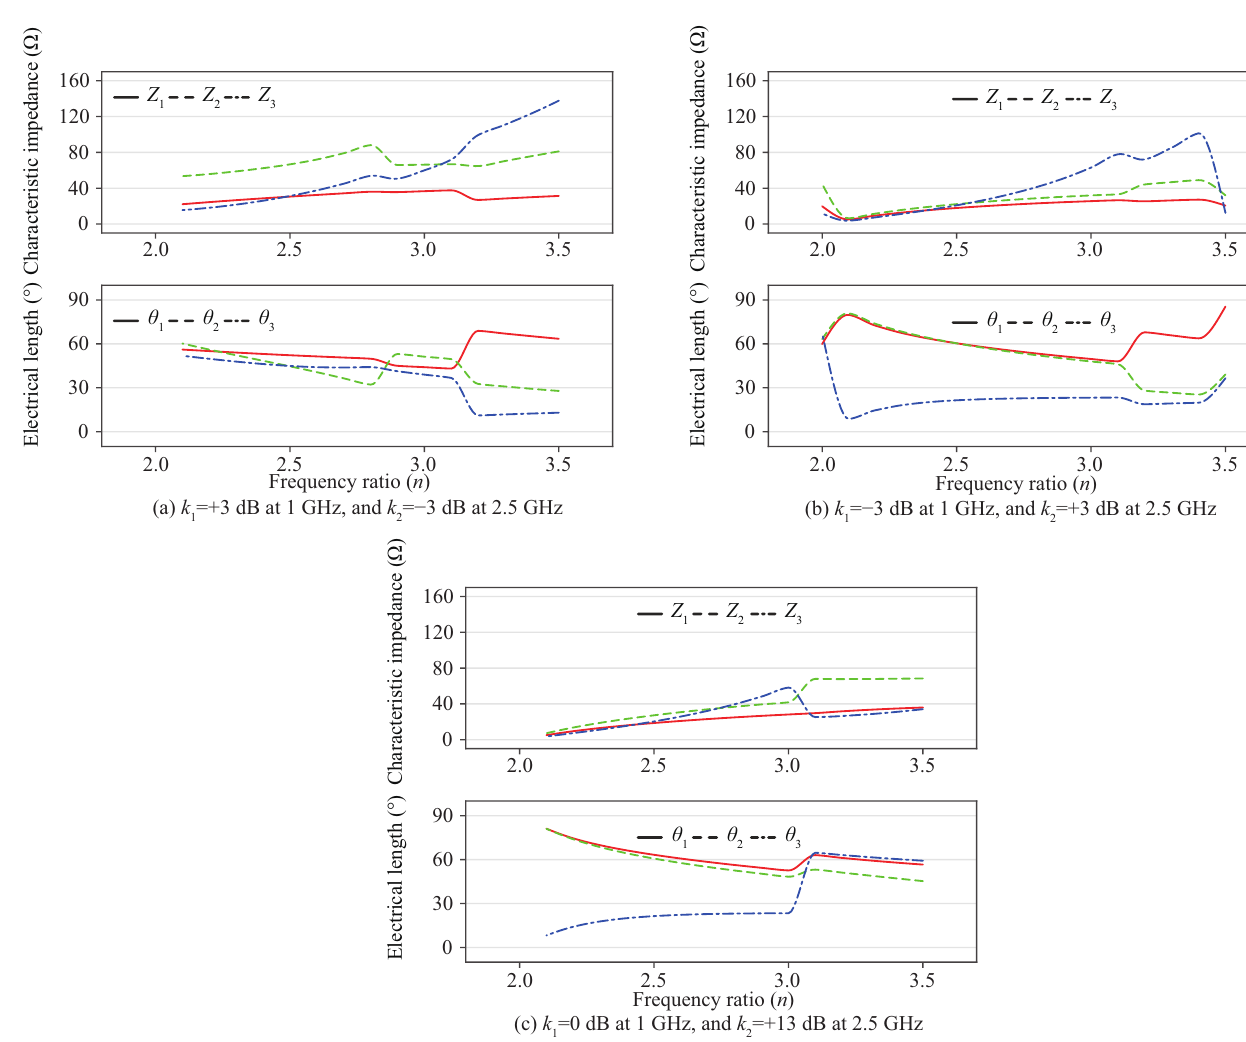
Figure 3. Design curves with respect to center frequency ratio n when Z 4 = 50 Ω and θ 4 = 180 ◦ / ( n + 1 )